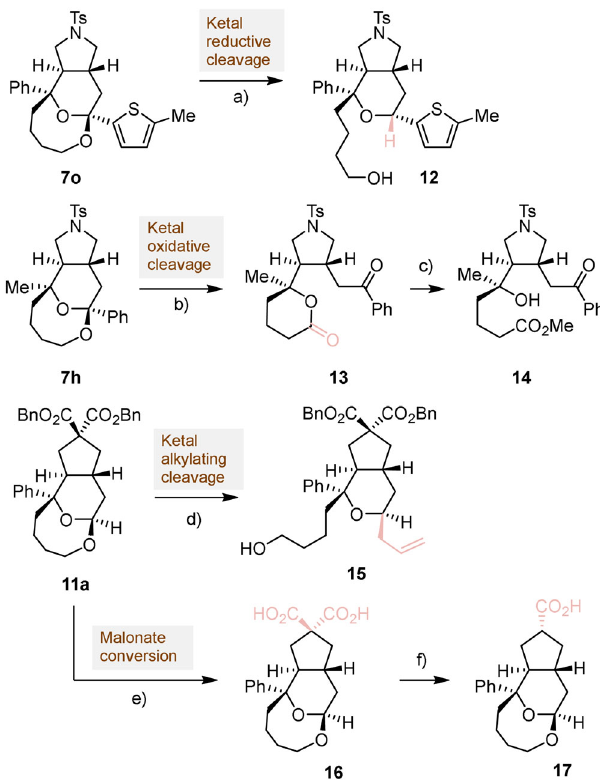
Fig. 5 Post-transformations of IEDHDA products. Reaction conditions: a DIBAL-H, CH 2 Cl 2 , 0 °C, 71% (d.r. = 7:1), 97%ee. b RuCl 3 , NaIO 4 , CH 3 CN/ CHCl 3 /H 2 O, RT, 45%, 93%ee. c K 2 CO 3 , MeOH, RT, 65%, 93%ee. d Allyltrimethylsilane, SnCl 4 , − 30 °C to RT, CH 2 Cl 2 , 68%, 95%ee. e Pd/H 2 , MeOH, quant.; f Pyridine, re fl ux, 78%, 95%ee.